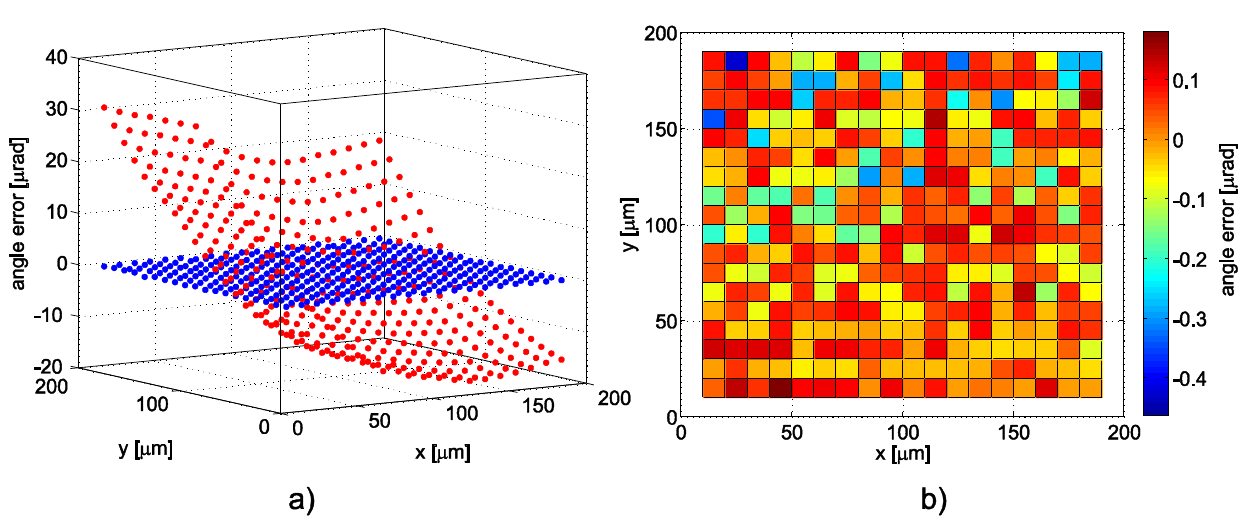
Figure 4. Angle guidance performance of the free-running stage. ( a ) without feedback control of angle—red; with full feedback control of the motion of the stage guidance errors—blue; ( b ) angle error over the whole field of motion with feedback control in